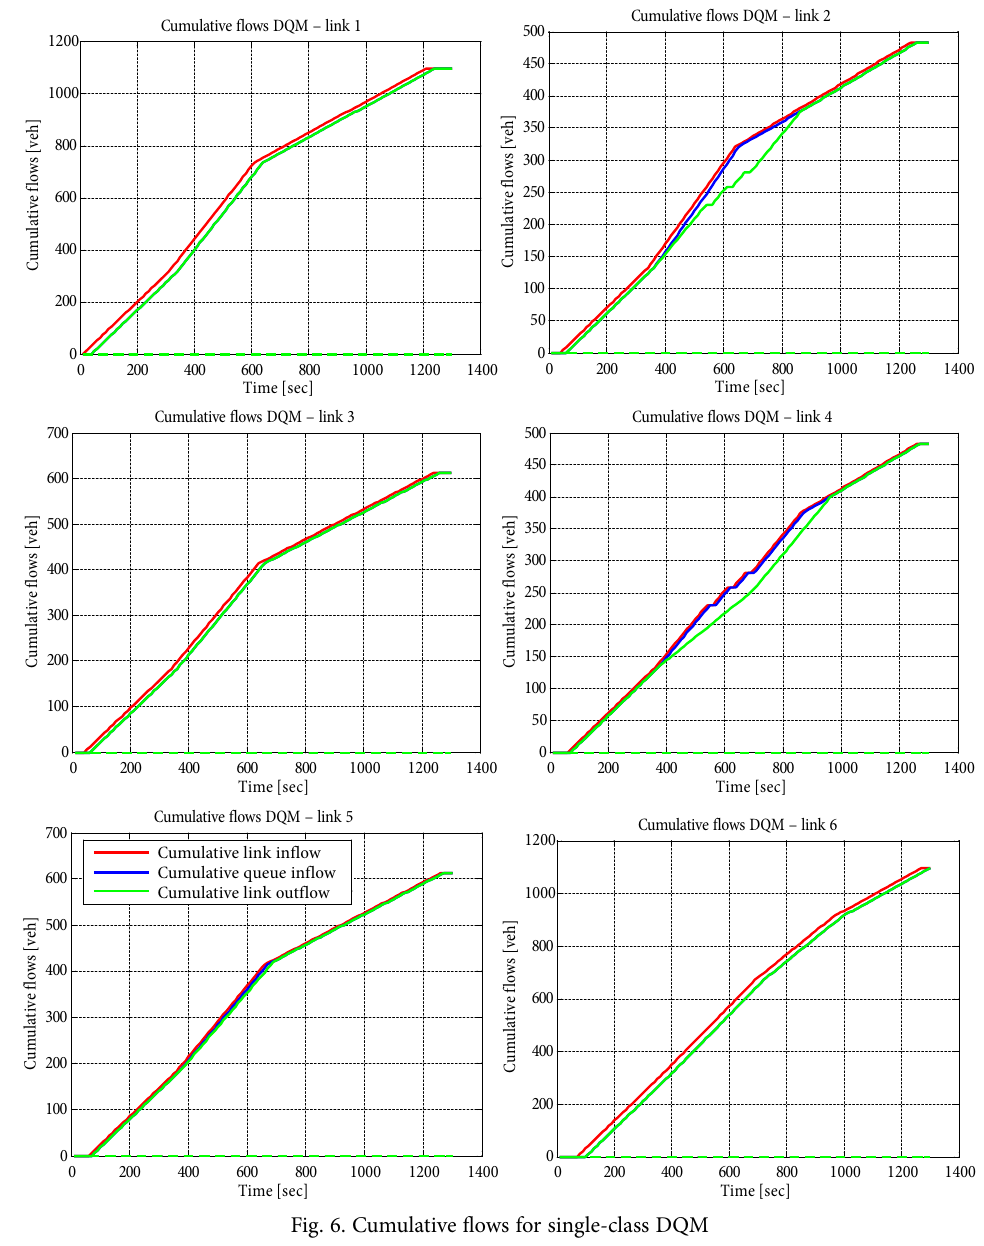
Fig. 6. Cumulative flows for single-class DQM